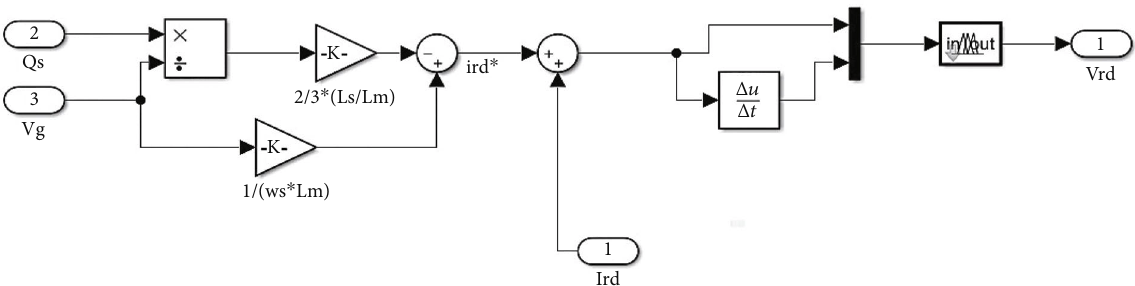
Figure 8: FLC for the stator reactive power in MATLAB Simulink.